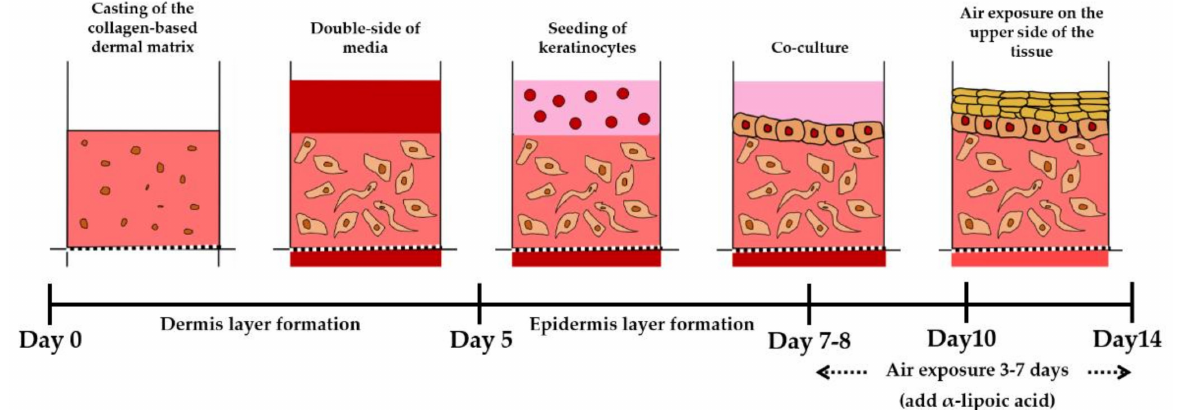
Figure 10. Schematic diagram of the 3D skin-model formation process in pumpless skin-on-a-chip (SOC). Skin equivalents are formed through air exposure on the 7th to 8th days after the initial culture is started, and at this time, a drug test is conducted by treating the culture medium with α -lipoic